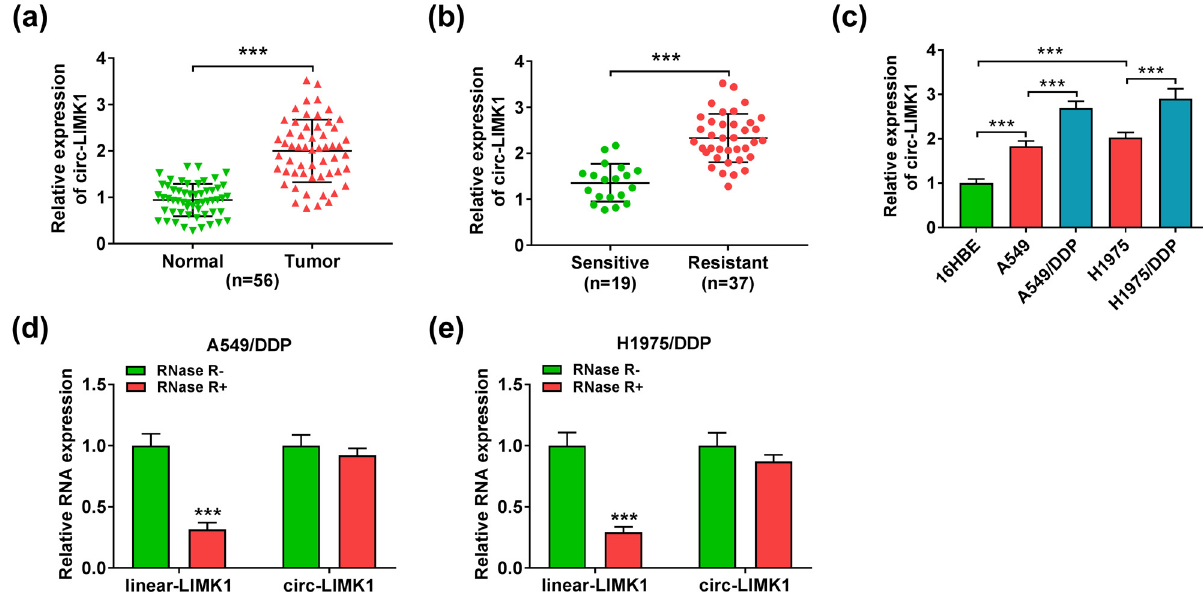
Figure 1: circ - LIMK1 was highly expressed in DDP - resistant tumor tissues and cells. ( a ) RT - qPCR was used to analyze the expression of circ - LIMK1 in normal tissues and tumor tissues. ( b ) RT - qPCR was performed to detect the expression of circ - LIMK1 in sensitive tumor tissues and resistant tumor tissues. ( c ) RT - qPCR was employed to analyze the expression of circ - LIMK1 in 16HBE, A549, A549/DDP, H1975, and H1975/ DDP cells. ( d and e ) RT - qPCR was used to measure the expression of circ - LIMK1 and linear LIMK1 in A549/DDP and H1975/DDP cells after RNase R digestion. *P < 0.05, ** P < 0.01, *** P <